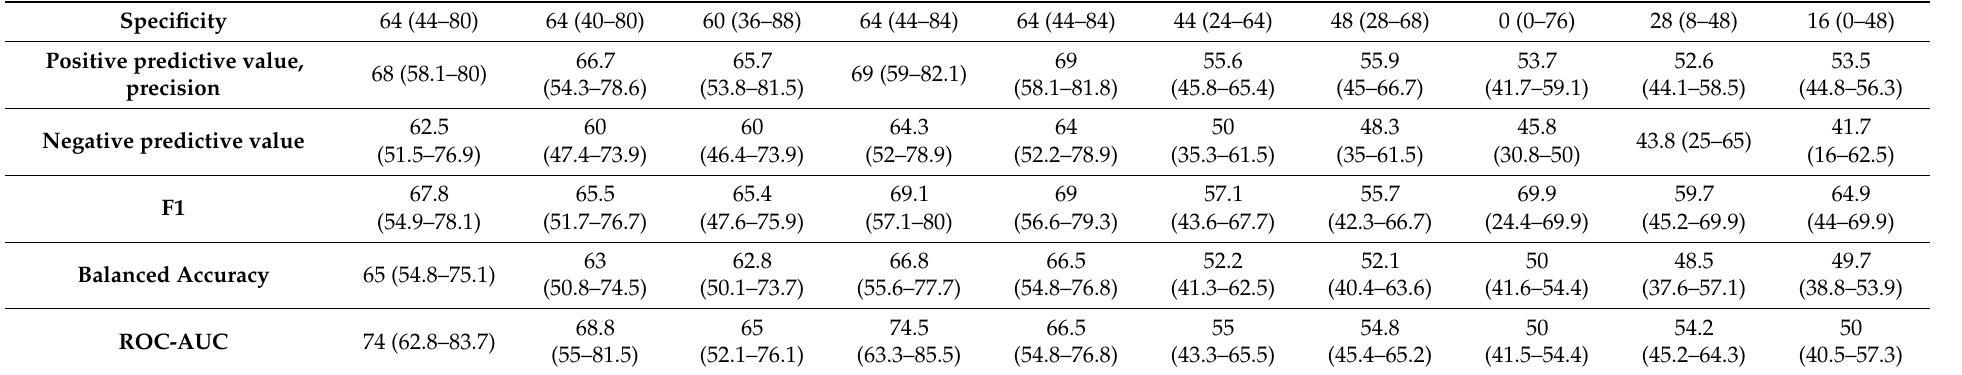
Table 4. Classification performance measures for correctly assigning subjects to olfactory dysfunction categories, either reduced anosmia function ( n = 1) or hyposmia, or normal olfactory function, obtained when training five different classifiers (random forests (RF), boosted classification and regression trees (ADA), C5.0 non-hierarchical decision rules, logistic regression (regression), and support vector machines (SVM)) with the metabolomics or olfactory information. The results represent the medians and 95% confidence intervals of the performance measures obtained during